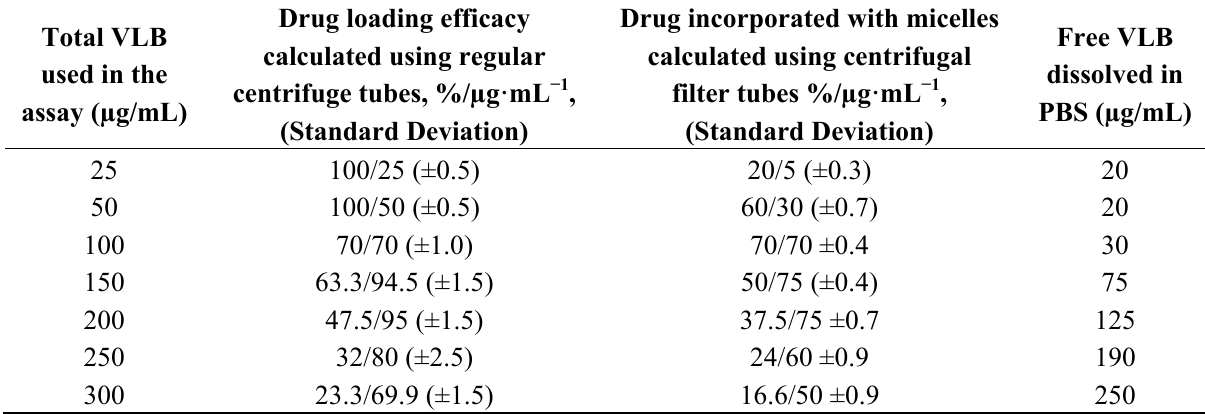
Table 3. Maximum solubility of vinorelbine (VLB) in 5 mg of micelles made of star-shaped polymer.